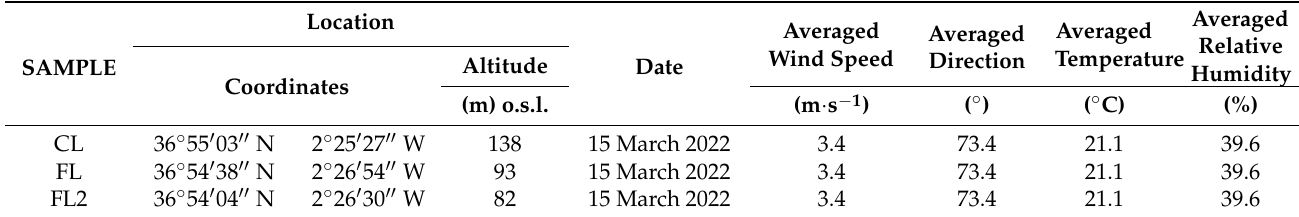
Table 1. Location and climatic characteristics of studied soils and